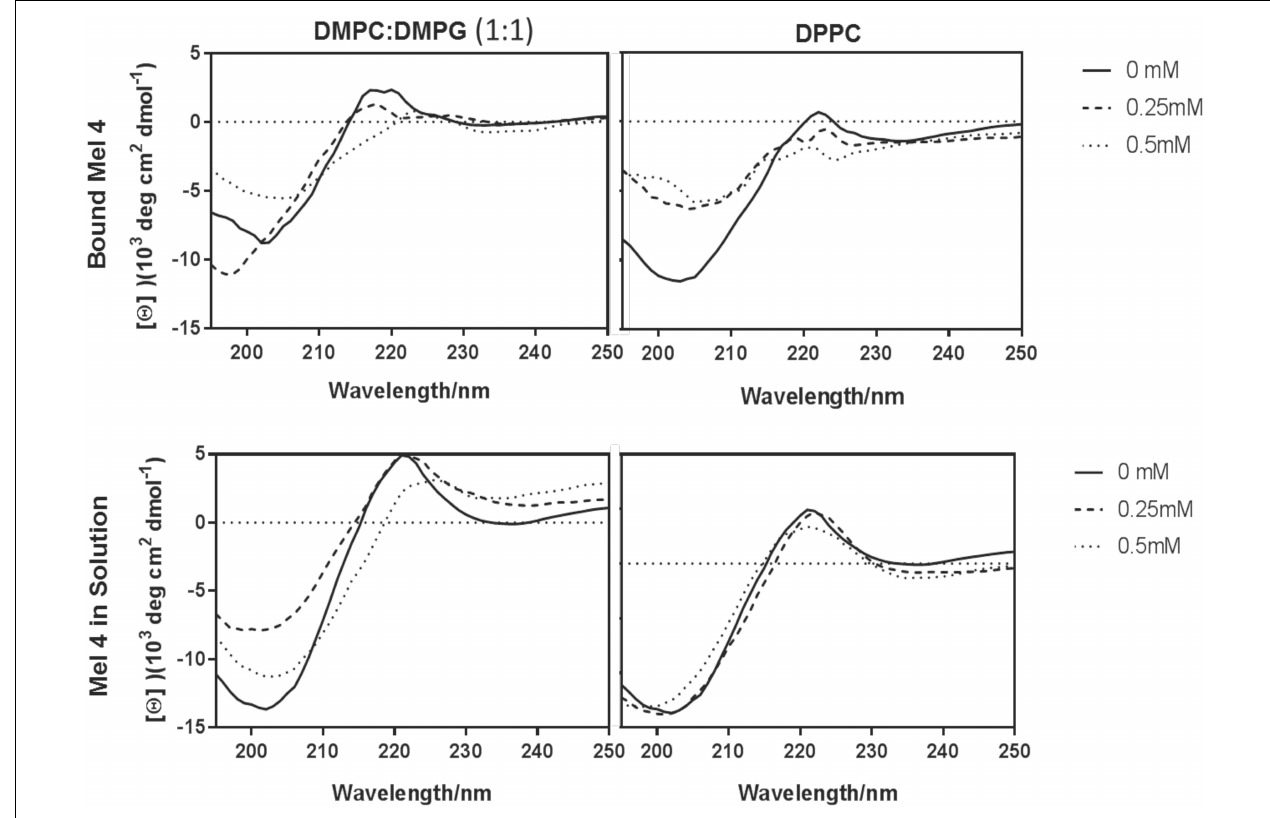
FIGURE 1 | Lipid interactions of immobilized and free Mel4. Interaction with DMPC:DMPG (1:1) (left) and DPCC (right). The samples in DMPC:DMPG and DPPC were analyzed without lipids (solid), or in the presence of 0.25 mM (dashed), and 0.5 mM (dotted) lipids.